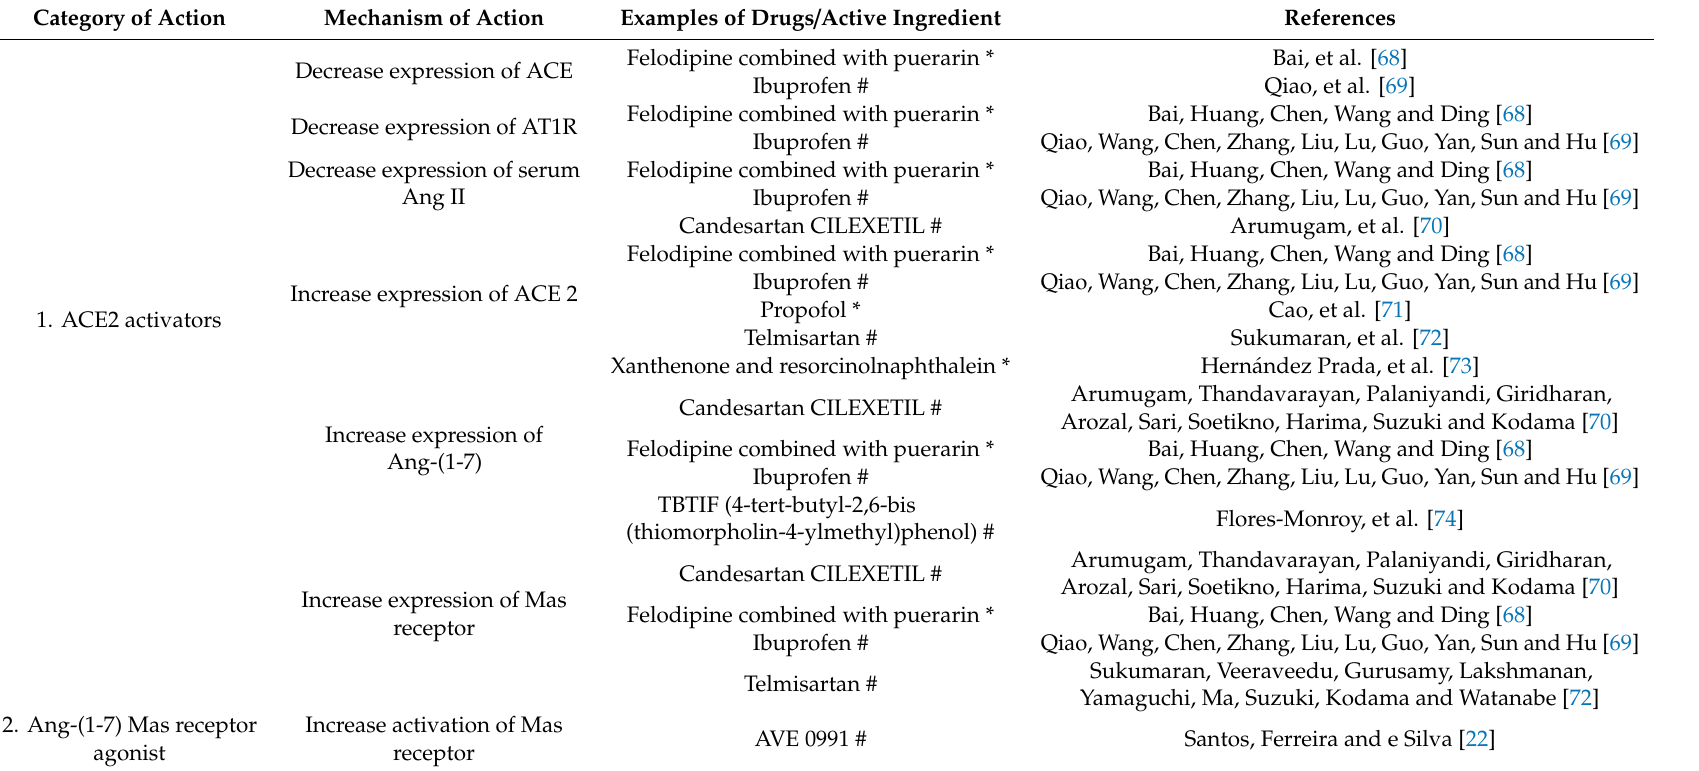
Table 2. Pharmaceutical drugs targeting the ACE2